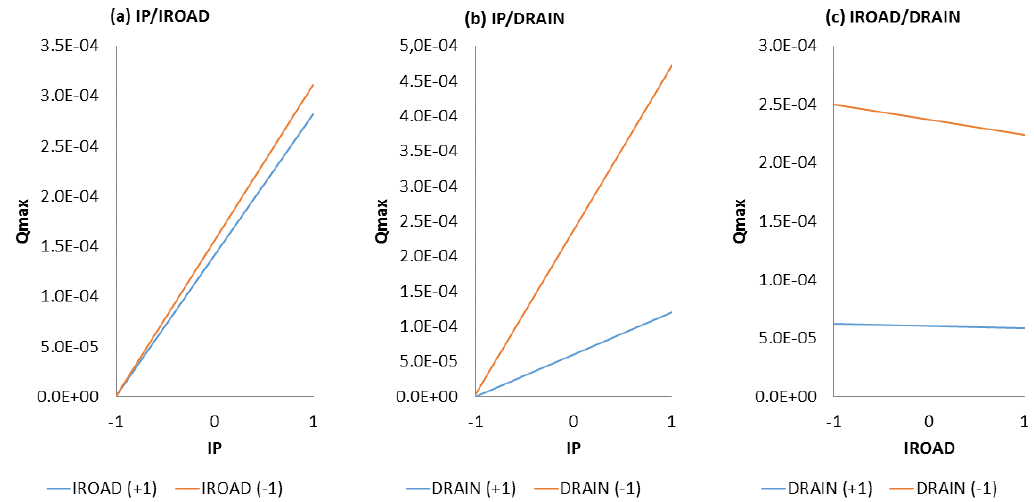
Figure 8. Interactions as a function of the maximum observed sewer runoff due to soil water infiltration during the 1994–1995 winter of the second order between parameters (a) I p and I rd ; (b) I p and D ∗ ; and (c) I rd and D ∗